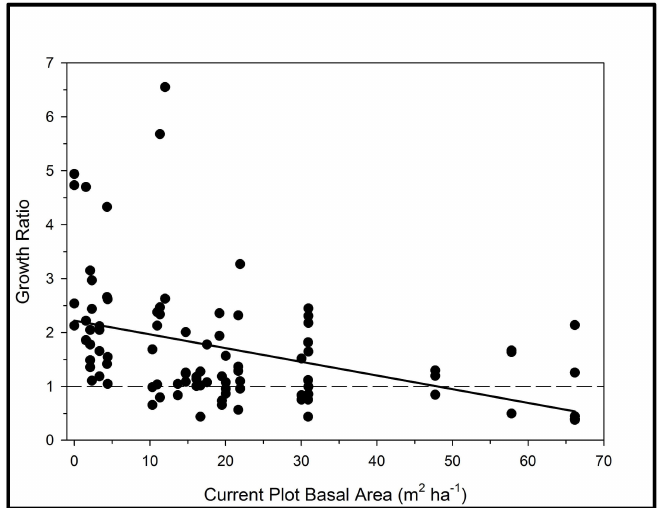
Figure 3. Relationship between growth ratio and plot basal area for all sample